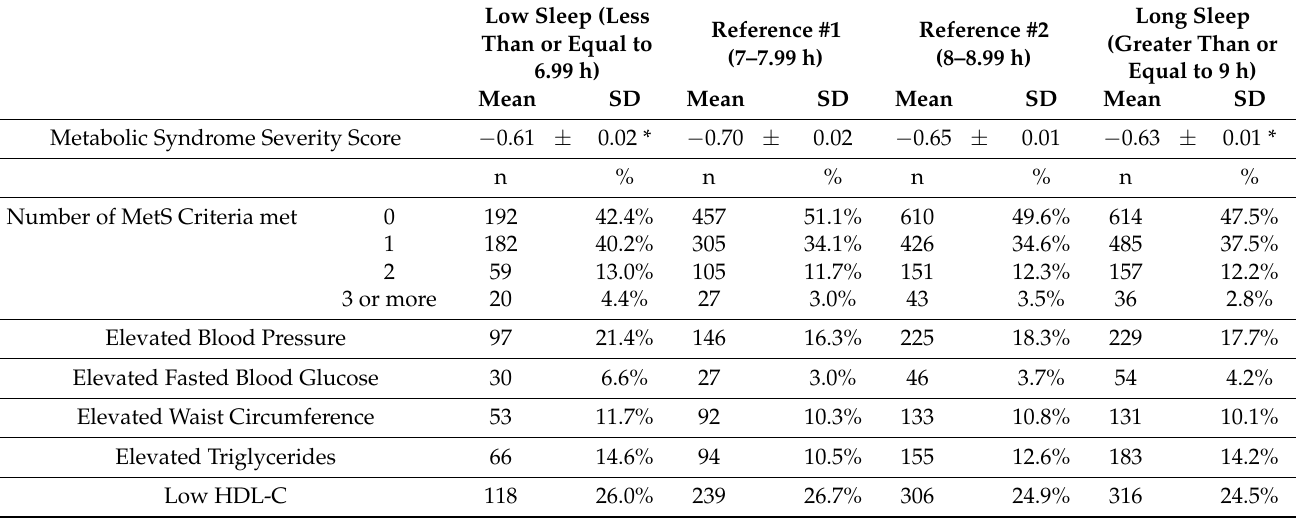
Table 3. Frequency of metabolic syndrome